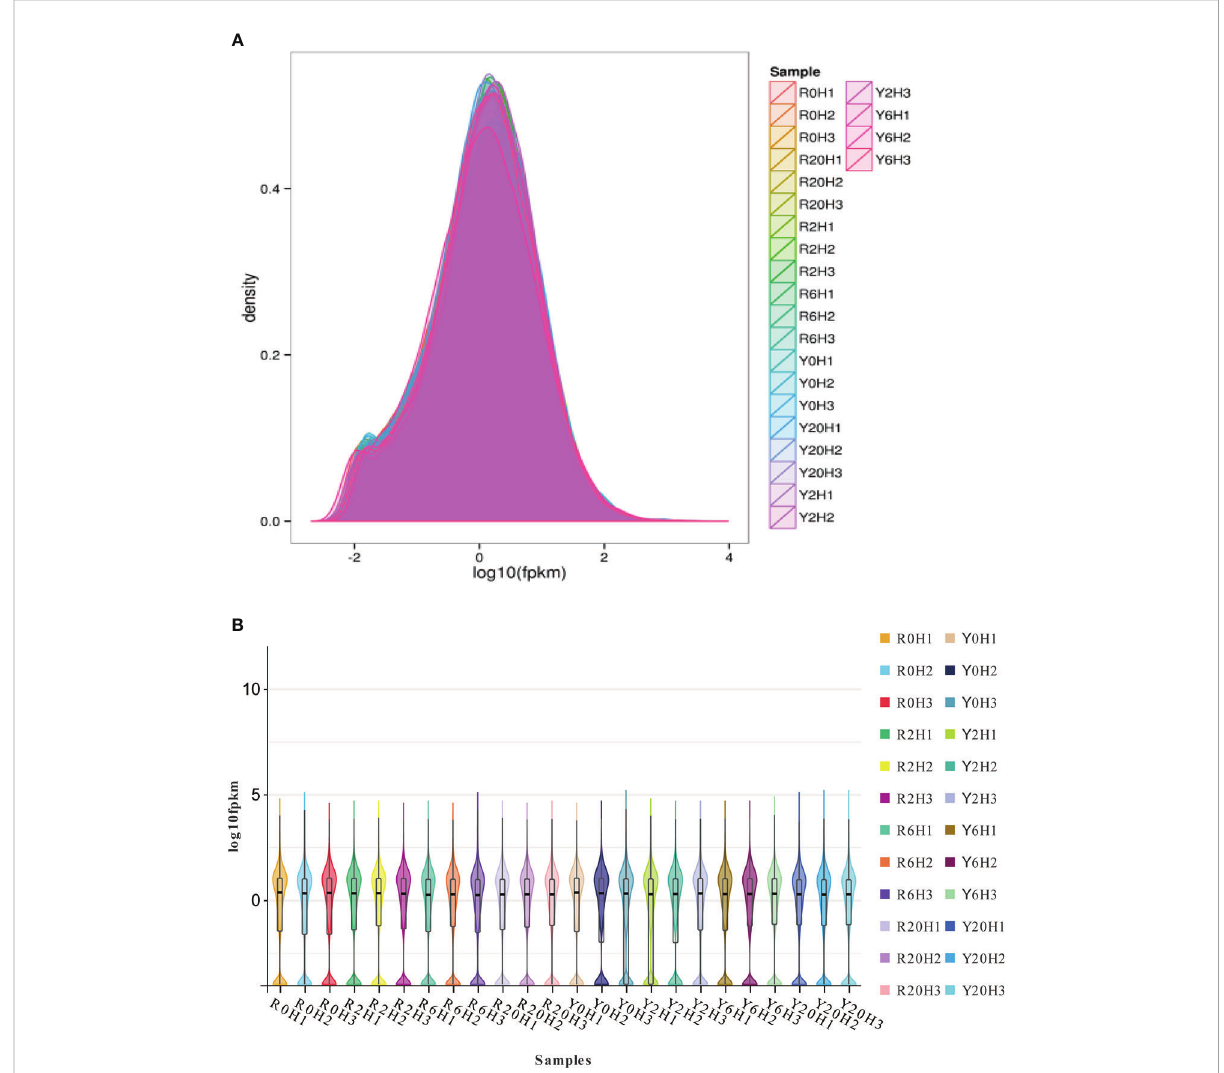
FIGURE 1 The gene expression density diagram and the violin plot for the transcripts of the rubber tree samples. (A) Gene expression density diagram. Comparison of FPKM density distribution. The curves in different colors represent different samples; the abscissa indicates the log value of the FPKM and the ordinate indicates the probability density. (B) Violin plot. The upper and lower ends of the lines represent the maximum and minimum of non-outliers; the upper and lower edges of the rectangles represent the third and fi rst quartiles of the data; the center dot represents the median of the